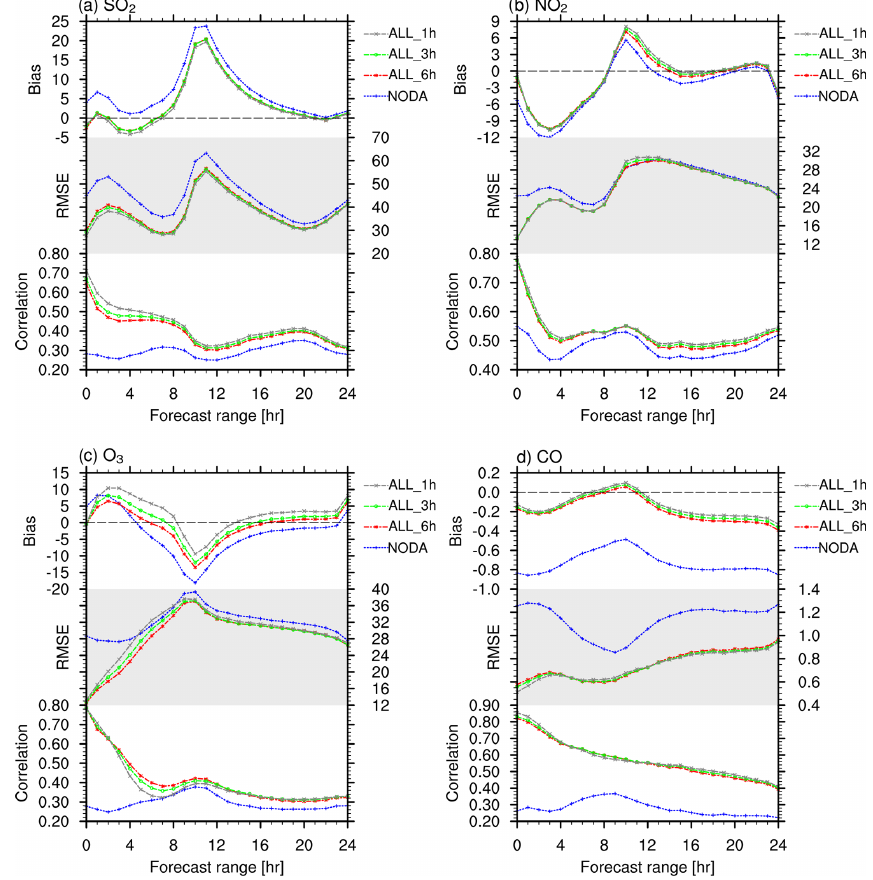
Figure 11. Same as Fig. 10, but for the forecast of (a) SO 2 , (b) NO 2 , (c) O 3 (units: µgm − 3 ), and (d) CO (units: mgm − 3 ).